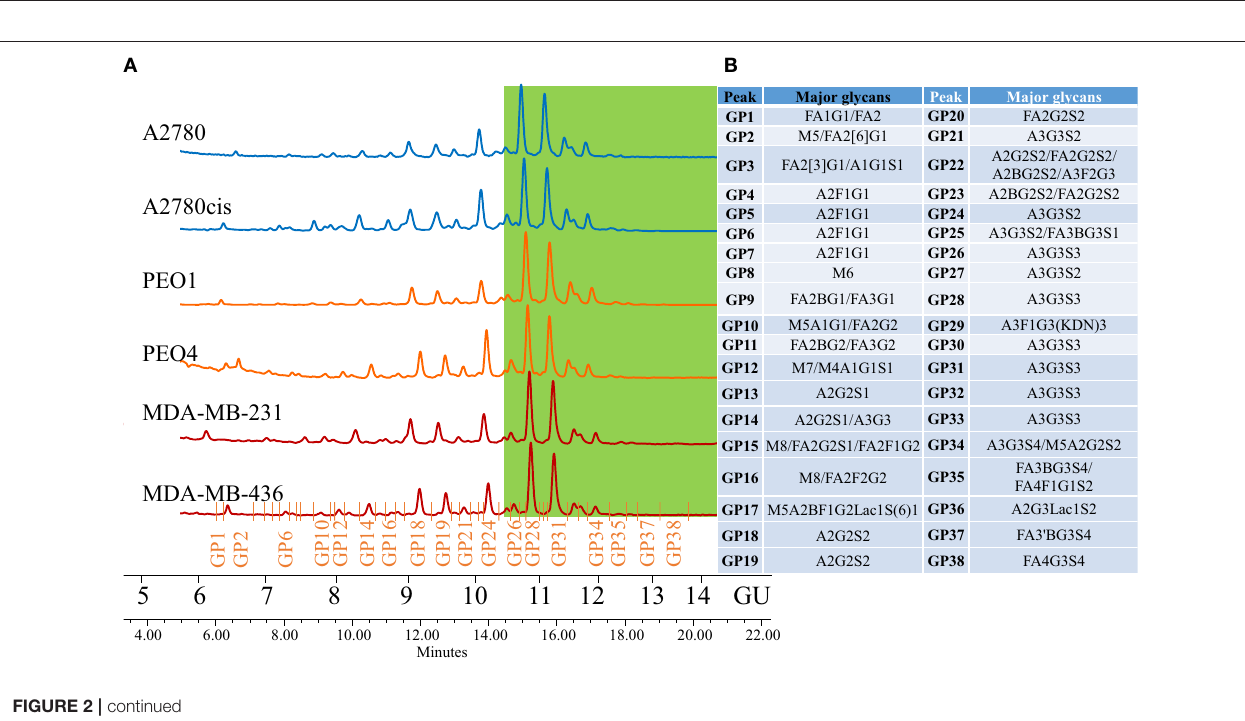
FIGURE 1 | Hypoxia alters global DNA methylation. The histogram represents the average global DNA methylation variation compared to a normoxic control for the 6 cell lines analyzed. Each cell line was exposed to 0.5, 1.0, and 2.0% for 24h (blue) and 48h (red). The error bars were calculated from the SD of 3 biological replicates. Significant changes are starred: * P ≤ 0.05; ** P ≤ 0.01; *** P ≤ 0.001 (one-way